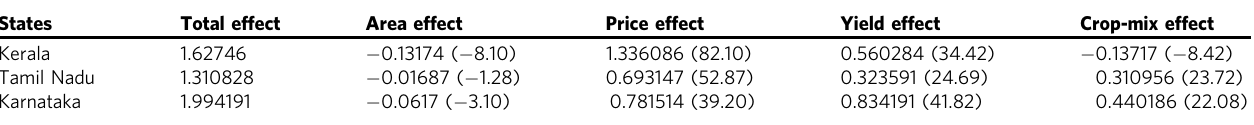
Table 3 Sources of coconut output in selected states in India from 2000 to 2017.